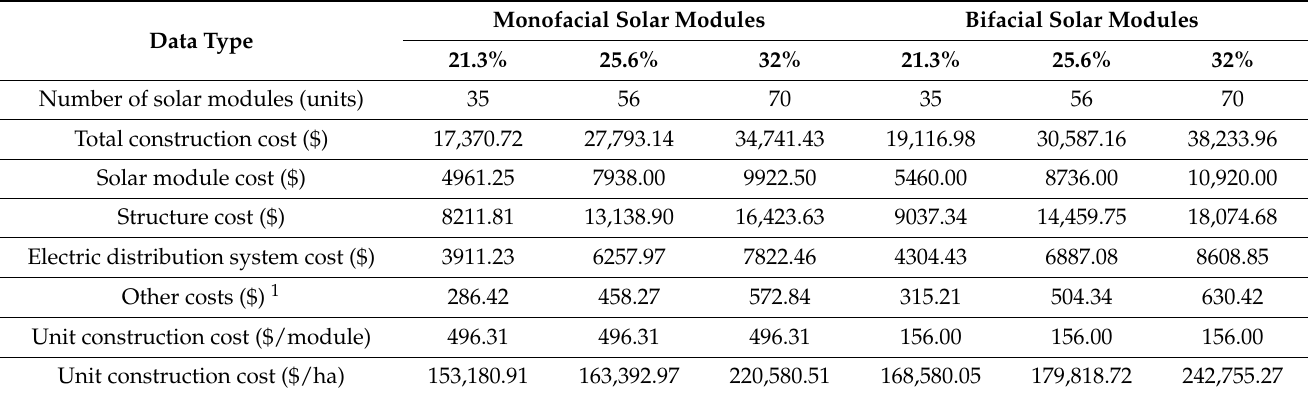
Table 1. Construction costs of the APV system.